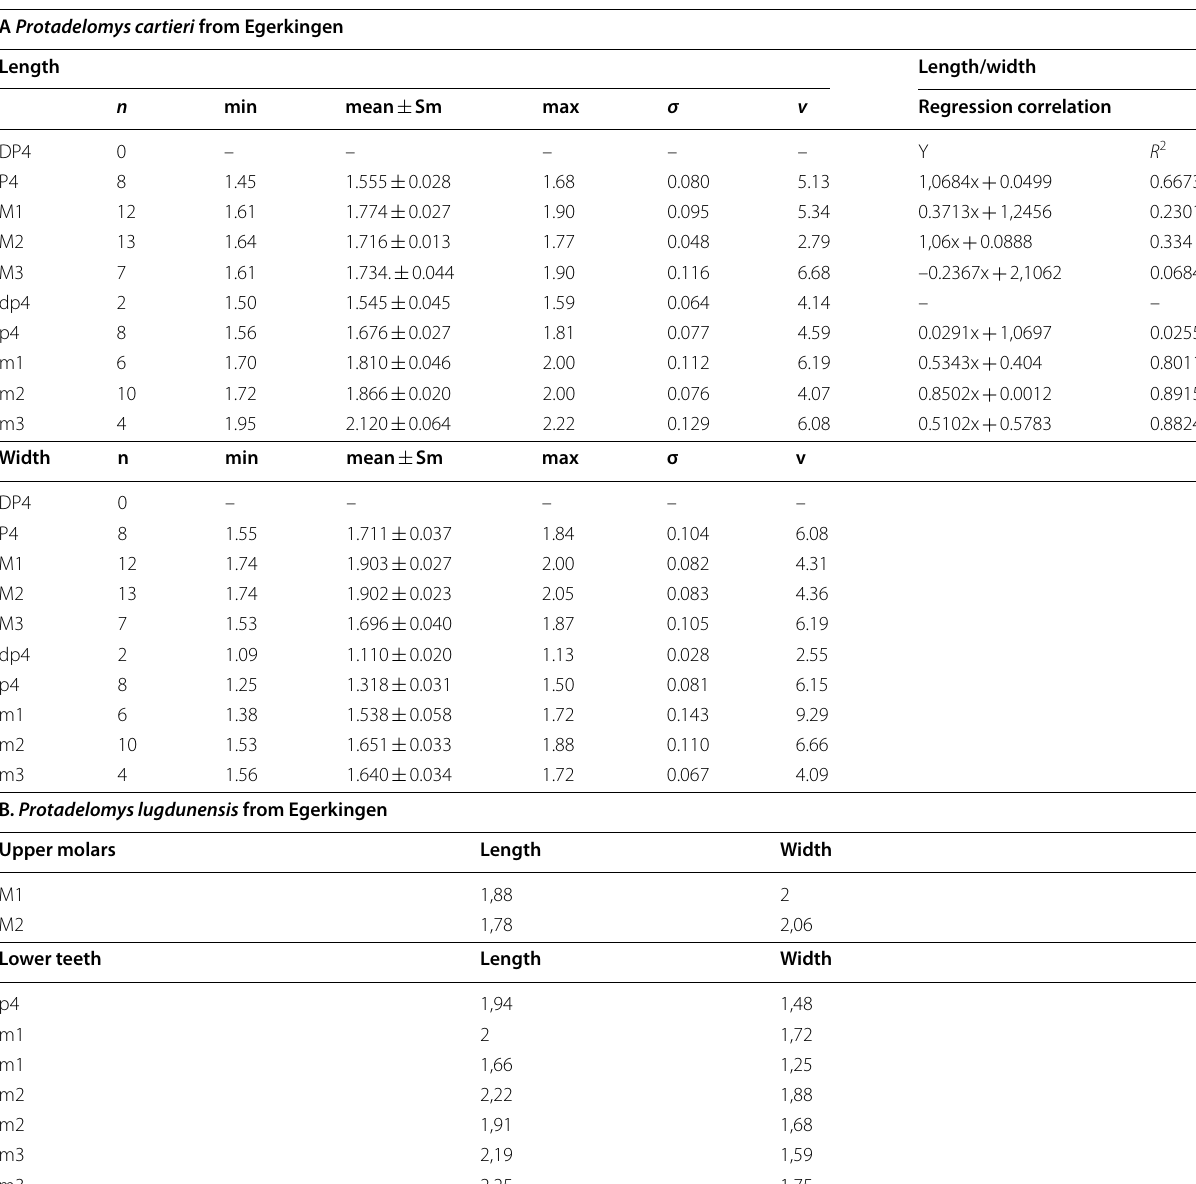
Sm σ/ √ n ; v 100 σ/average L or W): A. of the ± = =